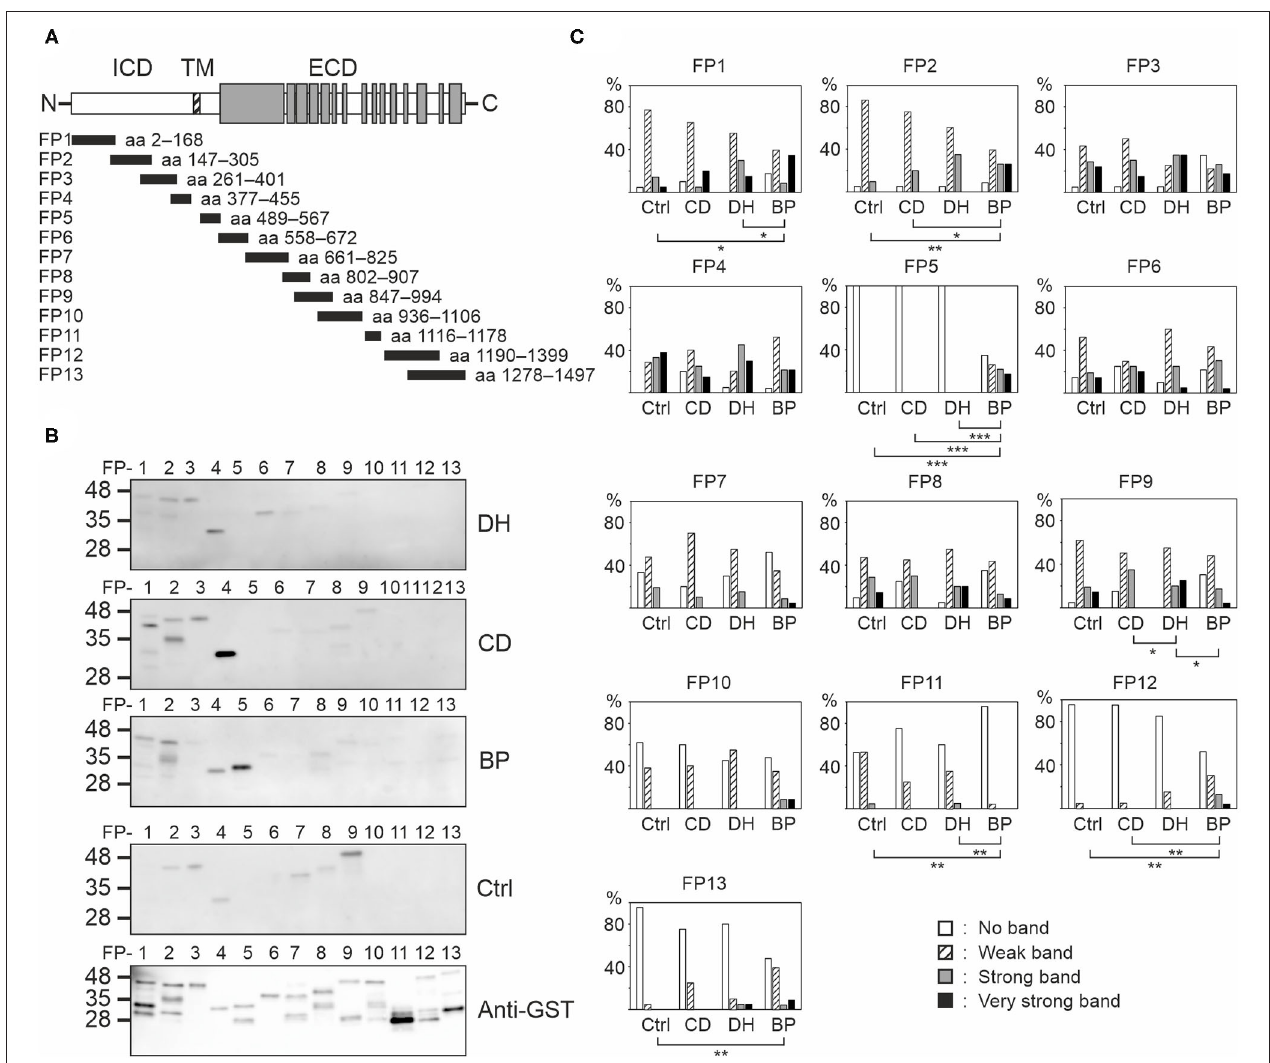
FIGURE 3 | Mapping of linear BP180 epitopes reveals differences between DH, CD, BP, and control sera. (A) Equal amounts of glutathione-S-transferase (GST)-BP180 fusion proteins were immunoblotted with 20 DH, 20CD, 23 BP, and 21 control serum samples and anti-human IgG secondary antibody. The gray areas depict collagenous domains. (B) Representative examples from each group are shown. (C) Relative frequencies of densitometrically classified immunoblotting signal intensities for indicated fusion proteins are shown. Statistically significant differences between groups are marked with asterisks, where two-sided P -values are: * P